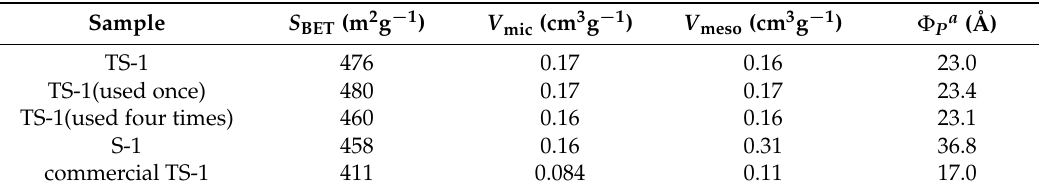
Table 2. Structural properties of the